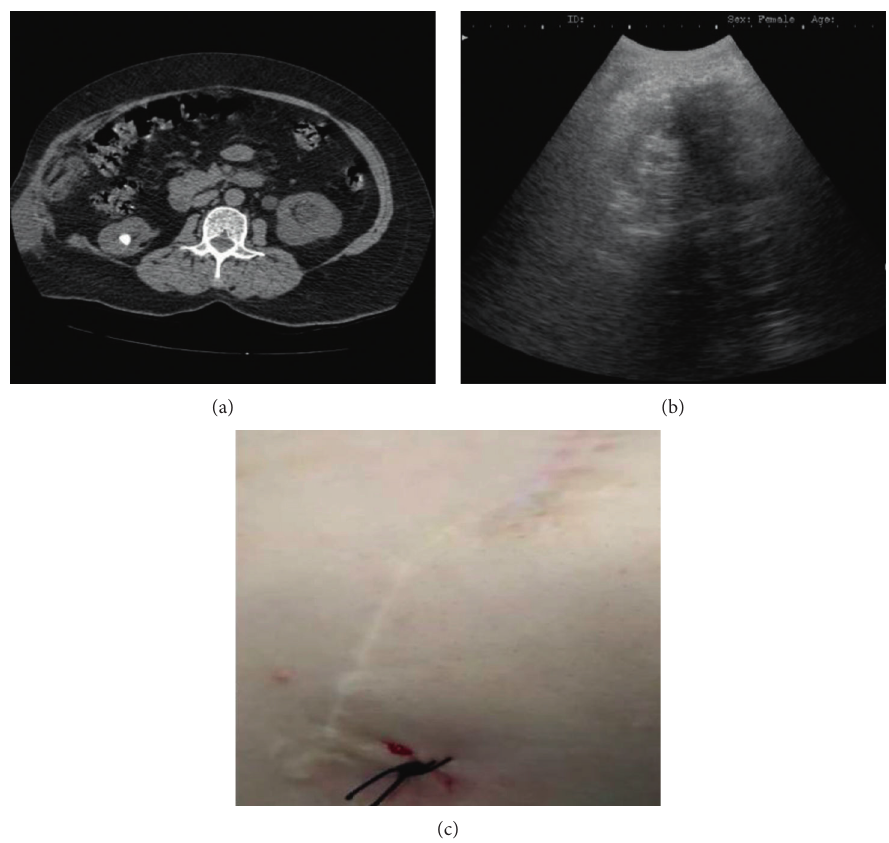
Figure 1: A 54-year-old woman with history of mesh-repaired right incisional flank hernia with right inferior calyx stone and left hydronephrosis; (a) CTscanning view, (b) ultrasound view of hypoechoic shadow of mesh, and (c) surgical hole of PNL and 2 incision lines in flank position for nephrolithotomy and hernia